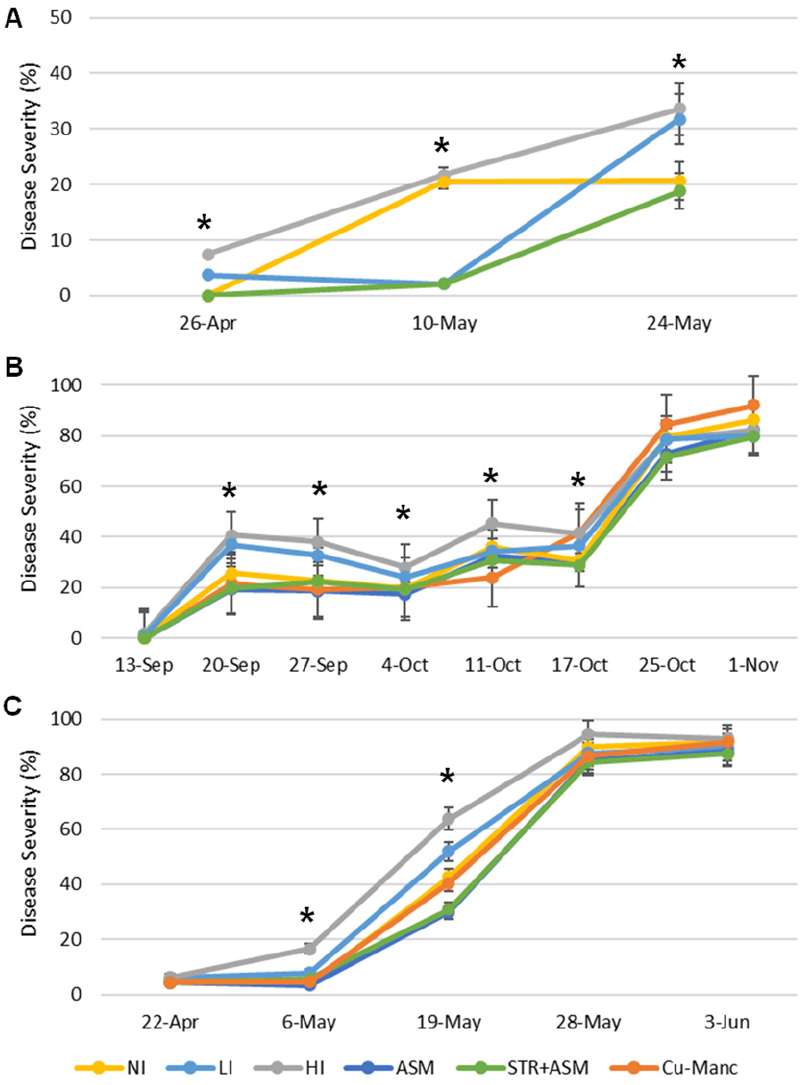
Figure 2. Effect of Xanthomonas perforans (Xp) inoculation level and bactericide treatments on tomato bacterial spot (BST) severity during individual trials conducted in ( A ) 2018, ( B ) 2019, and ( C ) 2020. Plot treatments included three inoculation treatments and three bactericide treatments. Inoculation treatments included a non-inoculated (NI) control and low inoculum (LI) and high inoculum (HI) treatments in which plots were inoculated either once after transplanting or were reinoculated every two weeks for six weeks after transplanting, respectively. The three bactericide treatments relied on natural inoculum movement from inoculated plots and included weekly applications of acibenzolar-S- methyl (ASM), streptomycin sulfate + ASM (STR+ASM), or copper hydroxide + mancozeb (Cu-Manc). Error bars represent standard errors, and an asterisk (*) above individual time points indicates that observed differences are statistically significant at the 95% level of